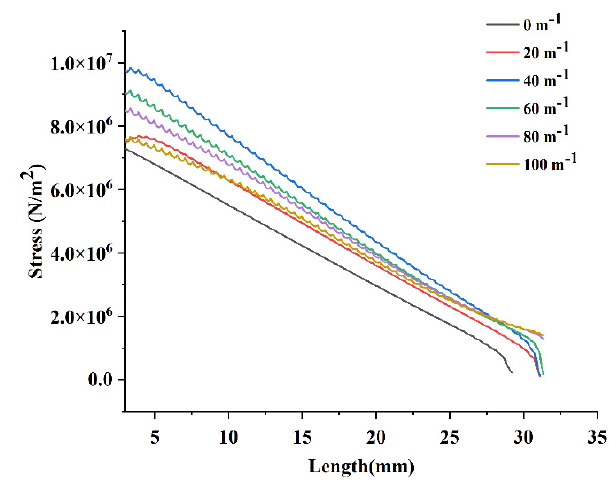
Figure 10. Stress-length diagram of the arc segment.